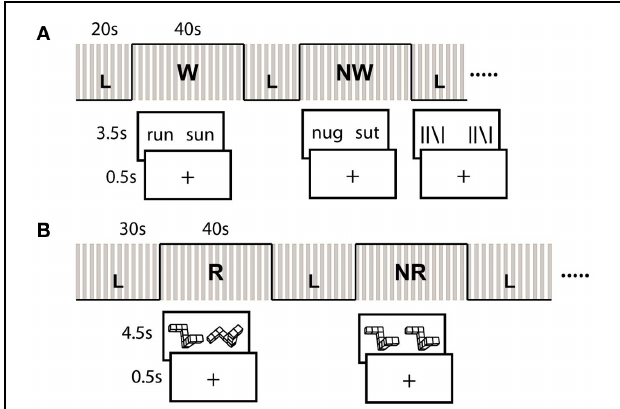
FIGURE 1 | fMRI Tasks and block design paradigm. (A) Verbal Tasks involved rhyme judgment for real word (W) and pseudo-word (NW) pairs. (B) Spatial tasks were adapted from Shepard and Metzler cubes and involved same/different judgment. Certain blocks required mental rotation (R) of the object to make this determination. Line control (L) task also involved same/different judgment. Gray bars represent timing of image acquisition for each